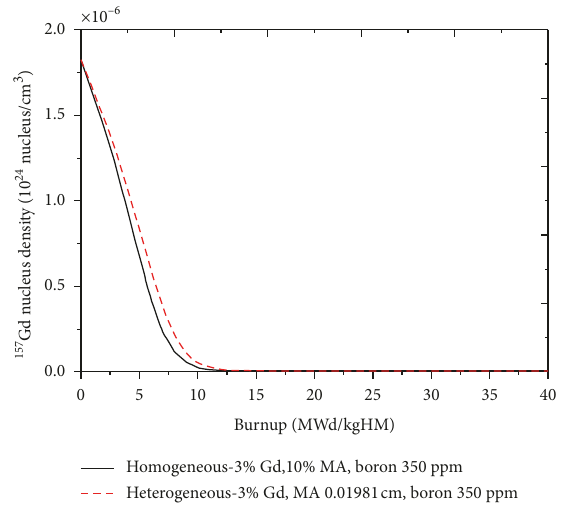
Figure 22: Comparison of the depletion of 155 Gd for two MA loading models.